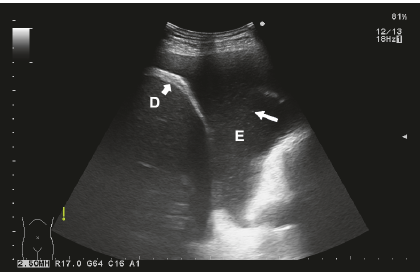
Figure 2: Typical ultrasonographic image of complex nonseptated malignant pleural effusion. Heterogeneously hyperechoic spots inside effusion (right white arrow) without fibrinous septations can be seen. D = diaphragm (left bold white arrow); E = pleural